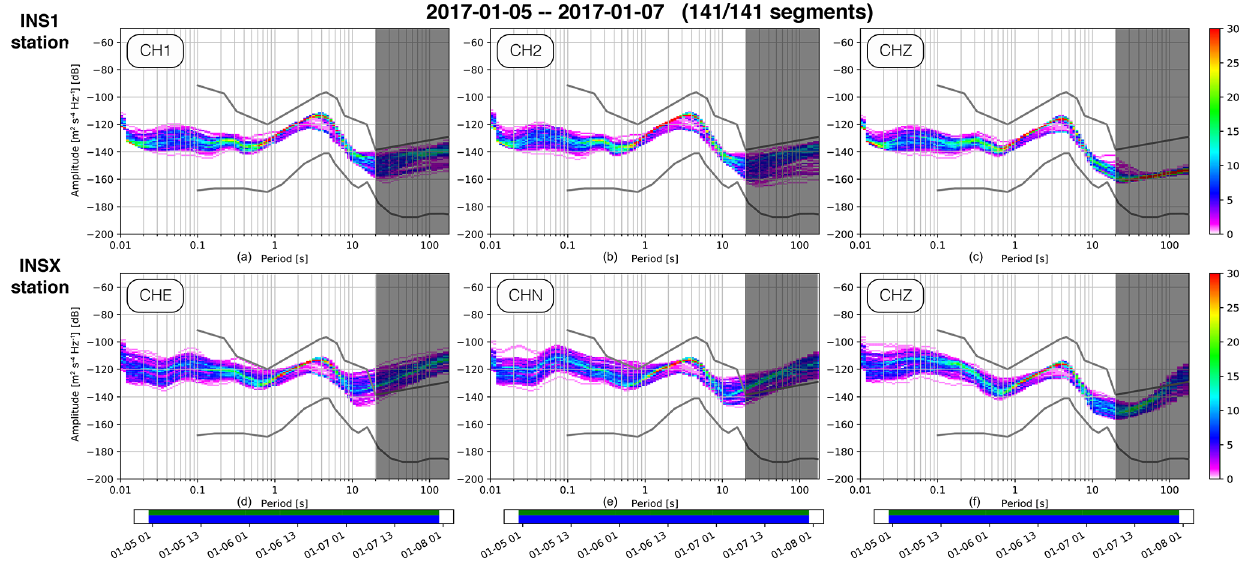
Figure 7. Probabilistic power spectral densities (PPSDs) computed for each component of the station INS1 (a, b, c) , with a sensor installed at 50m depth, and the station INSX (d, e, f) , with a sensor installed at the surface. The colour palettes on the right indicate the probability (in percentage) of having a certain noise level. The two grey curves in each panel indicate the new high- and low-noise models, respectively, obtained by Peterson (1993). Below all PPSD panels the data basis is visualized: the top row is coloured in green for available data and in red (not in this case) for eventual gaps in streams. The bottom row is coloured in blue if the single PSD measurement is included in the PPSD computation. Periods above 20s are highlighted in grey because in such a period range it is not possible to compare the PPSD of the two stations (only the sensor of INS1 stations has a flat response up to